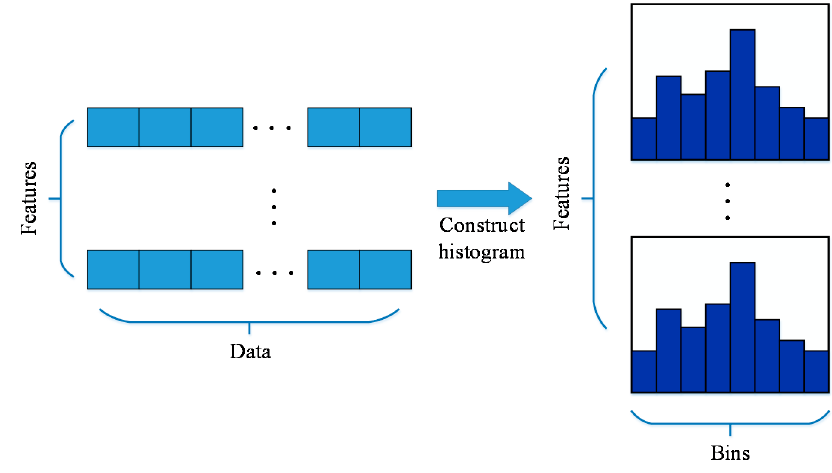
Figure 5. Histogram algorithm.